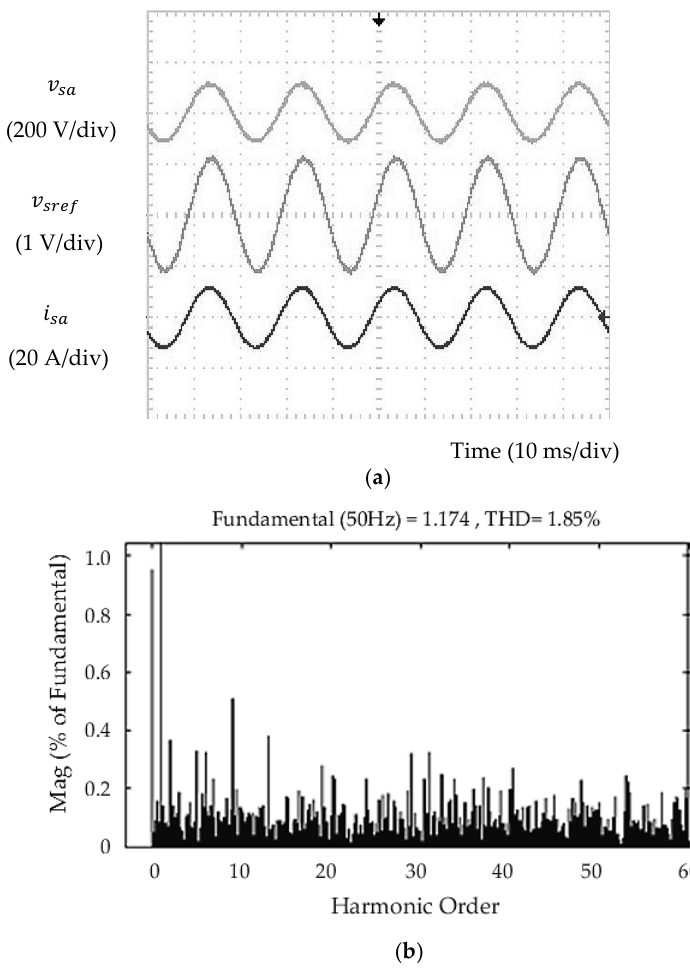
Figure 16. Experimental results obtained, which include: ( a ) Phase A input voltage, reference voltage, input current, and ( b ) total harmonic distortion (THD) of input current.